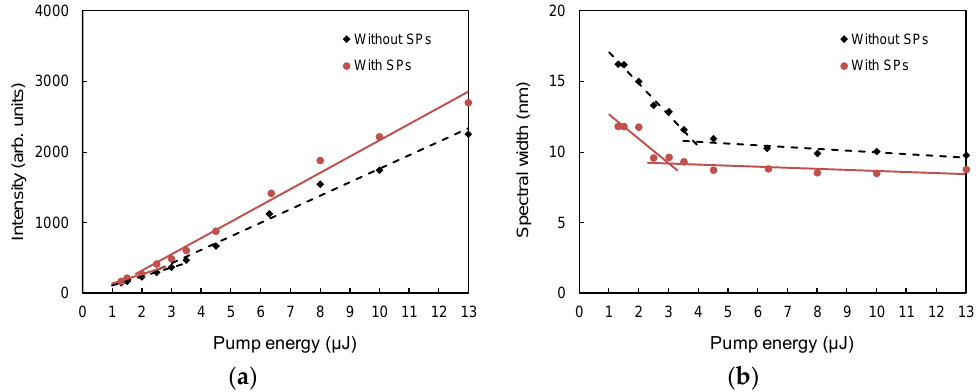
Figure 4. ( a ) Peak intensity of the emission spectra versus pump energy. ( b ) Full width at half maximum of emission spectra versus pump energy. The black rhombuses and red circles represent the homogeneous and BS media, respectively. The volume fraction of scattering particles is 10%, and the volume fraction of SPs in the BS medium is 10%.